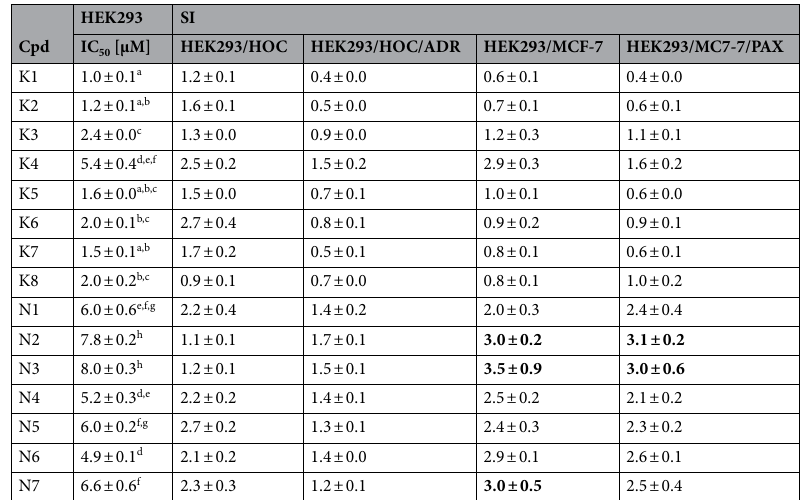
Table 2. Cytotoxic potential of selenoesters against non-cancerous cell line HEK293 with the corresponding therapeutic index. Data are expressed as the average inhibitory concentration (IC 50 ) and selectivity index (SI) of three repetitions with standard error of the mean (SEM). The selectivity is considered as strongly selective, when SI value is higher than 6, moderately selective when 6 > SI > 3, slightly selective when 3 > SI > 1 and non- selective if SI is less than 1. The statistical differences between compounds were calculated by one-way analysis of variance (ANOVA) and Duncan’s post hoc test (p ˂ 0.05), where the significances were denoted by different letters (a–h). Significant values are in